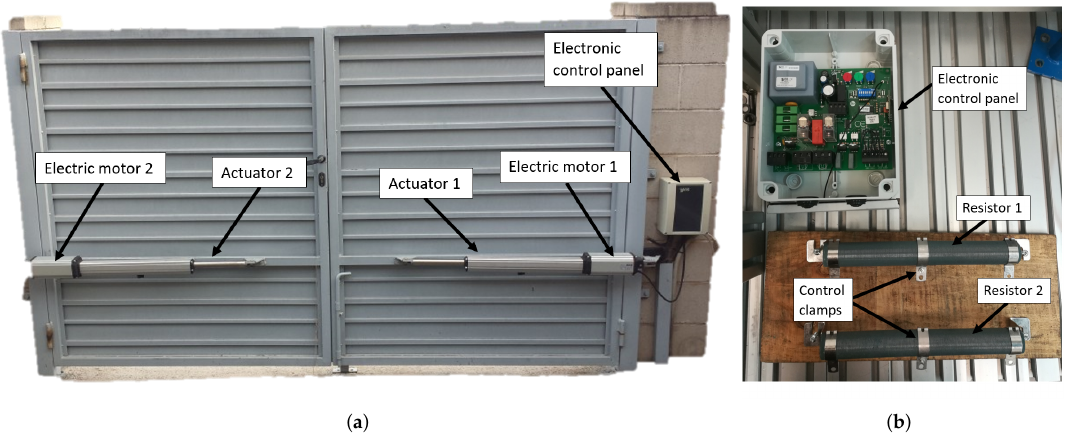
Figure 1. The study case used to develop and assess the predictive module: ( a ) configuration in real conditions; ( b ) simulated configuration at the laboratory